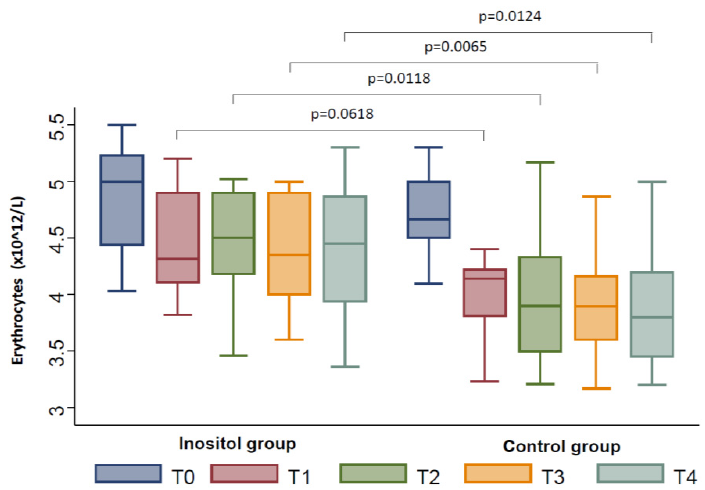
Figure 2. Changes from baseline in erythrocytes between the Inositol Group and the Control Group during the follow-up (T1–T4).